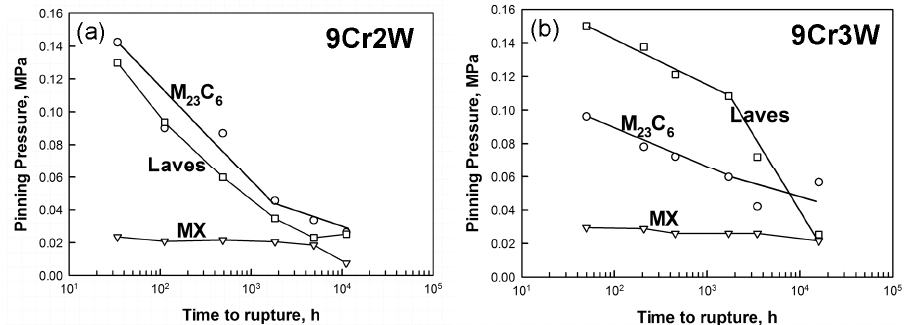
Figure 8. Change in the pinning pressures from different kinds of particles on the grain and lath boundaries of the ( a ) 9Cr2W steel and ( b ) 9Cr3W steel during creep tests at 650 °C under the stresses of 100–220 MPa.